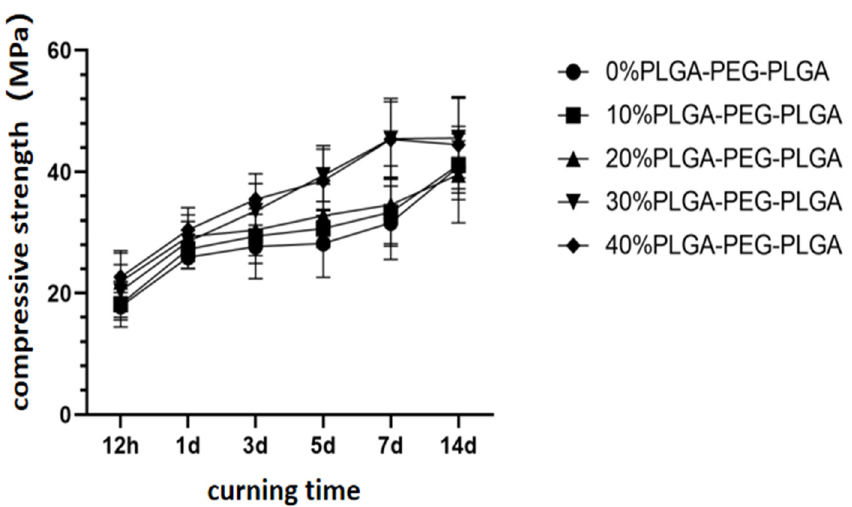
Figure 5. Changes in the compressive strengths of composite bone cements with different PLGA– PEG–PLGA thermosensitive hydrogel contents with curing time.